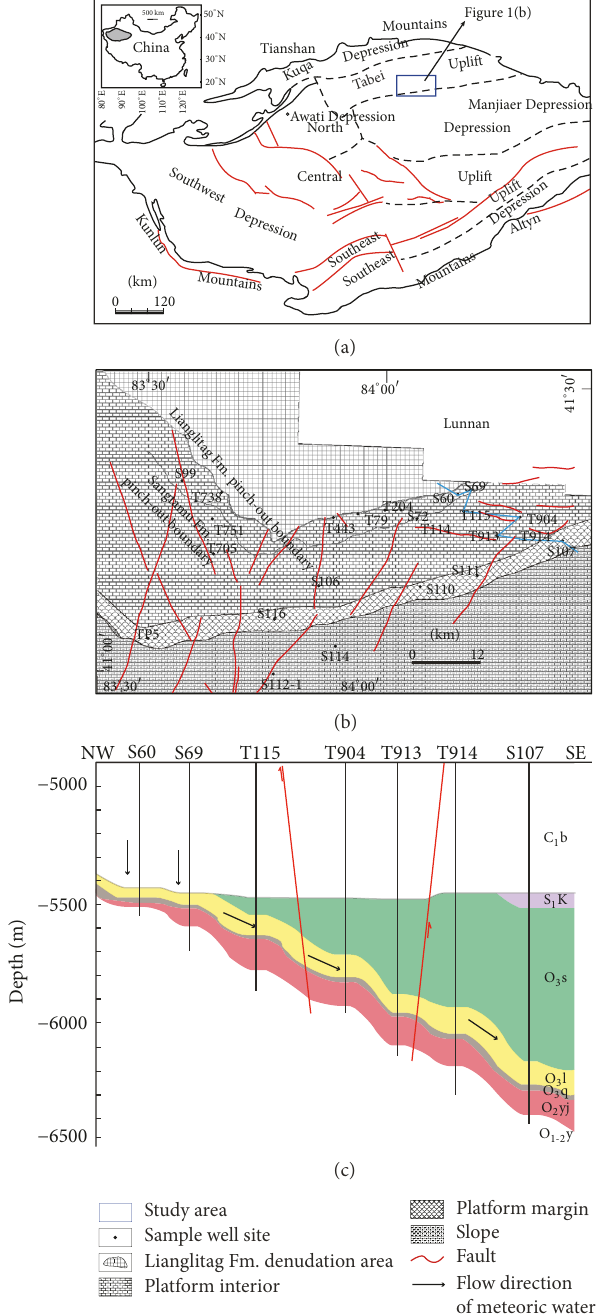
Figure 1: Tectonic subdivisions and location of the study areas. (a) Tectonic unit divisions of the Tarim Basin and location of the study areas. (b) Distribution of sample wells in the Tahe study region. (c) Strata profile from Well S60 to Well S107 (please see the blue line in (b)).